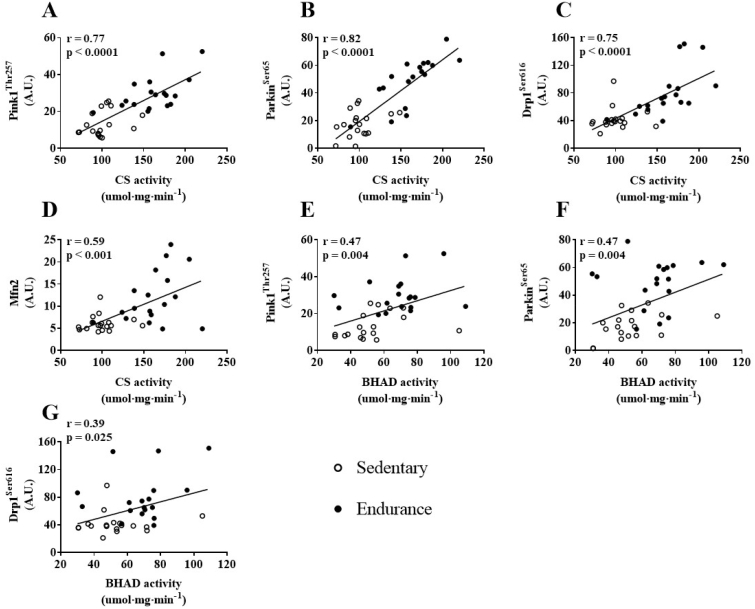
Correlations between skeletal muscle citrate synthase (CS) activity and β-hydroxyacyl-CoA dehydrogenase (BHAD) activity compared to content of skeletal muscle mitophagy and mitochondrial dynamic proteins. (A&B) CS activity and phospho-Pink1Thr257, (C&D) CS activity and phospho-ParkinSer65, (E&F) CS activity and phospho-Drp1Ser616, (G&H) BHAD activity and phospho-ParkinSer65. Correlations were based on fasted and post-HFM data point.